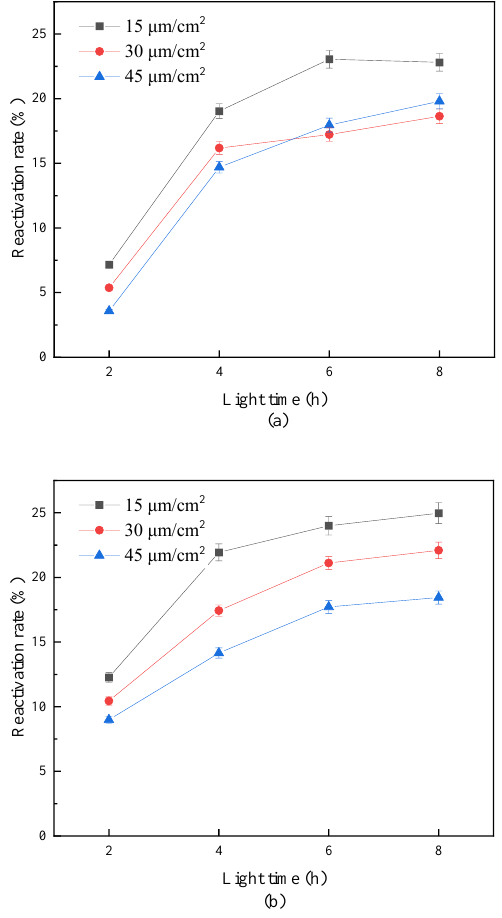
Figure 6. Effect of different light intensity on photoreactivation of fecal coliforms. ( a ) “Method A”; ( b ) “ Method B” .